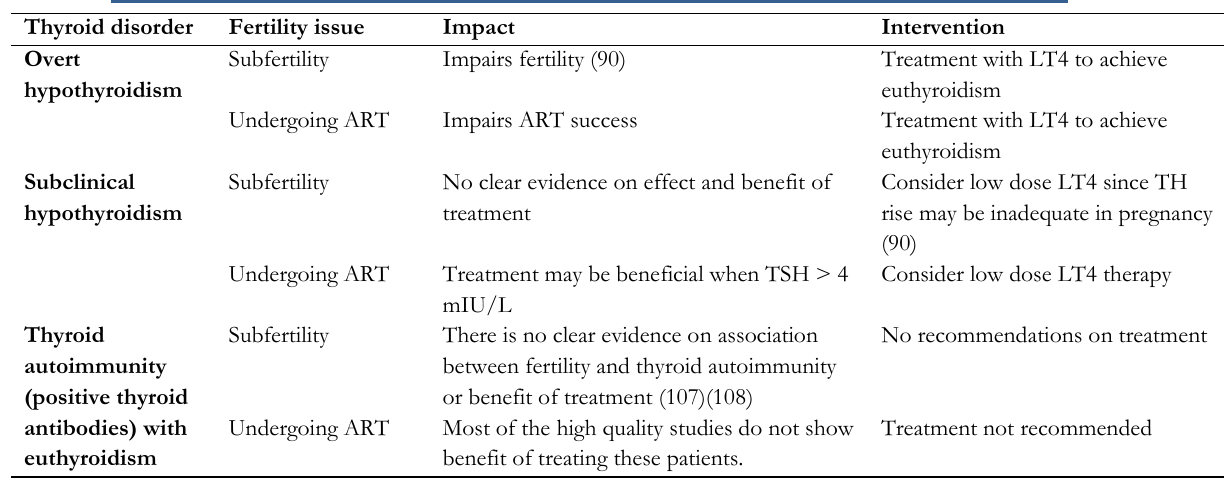
Table 4.6. Hypothyroidism and thyroid autoimmunity in fertility